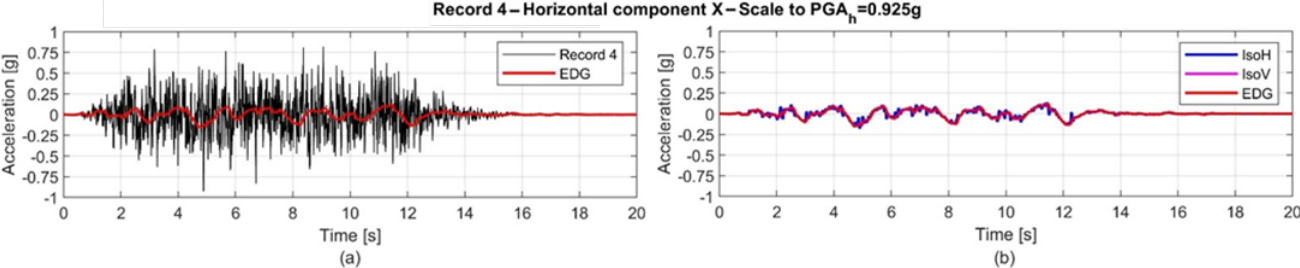
Figure 7. Horizontal acceleration time history results for Record 4 with PGA = 0.925 g—direction “X”. ( a ) Record and EDG response comparison; ( b ) System response by isolation level.